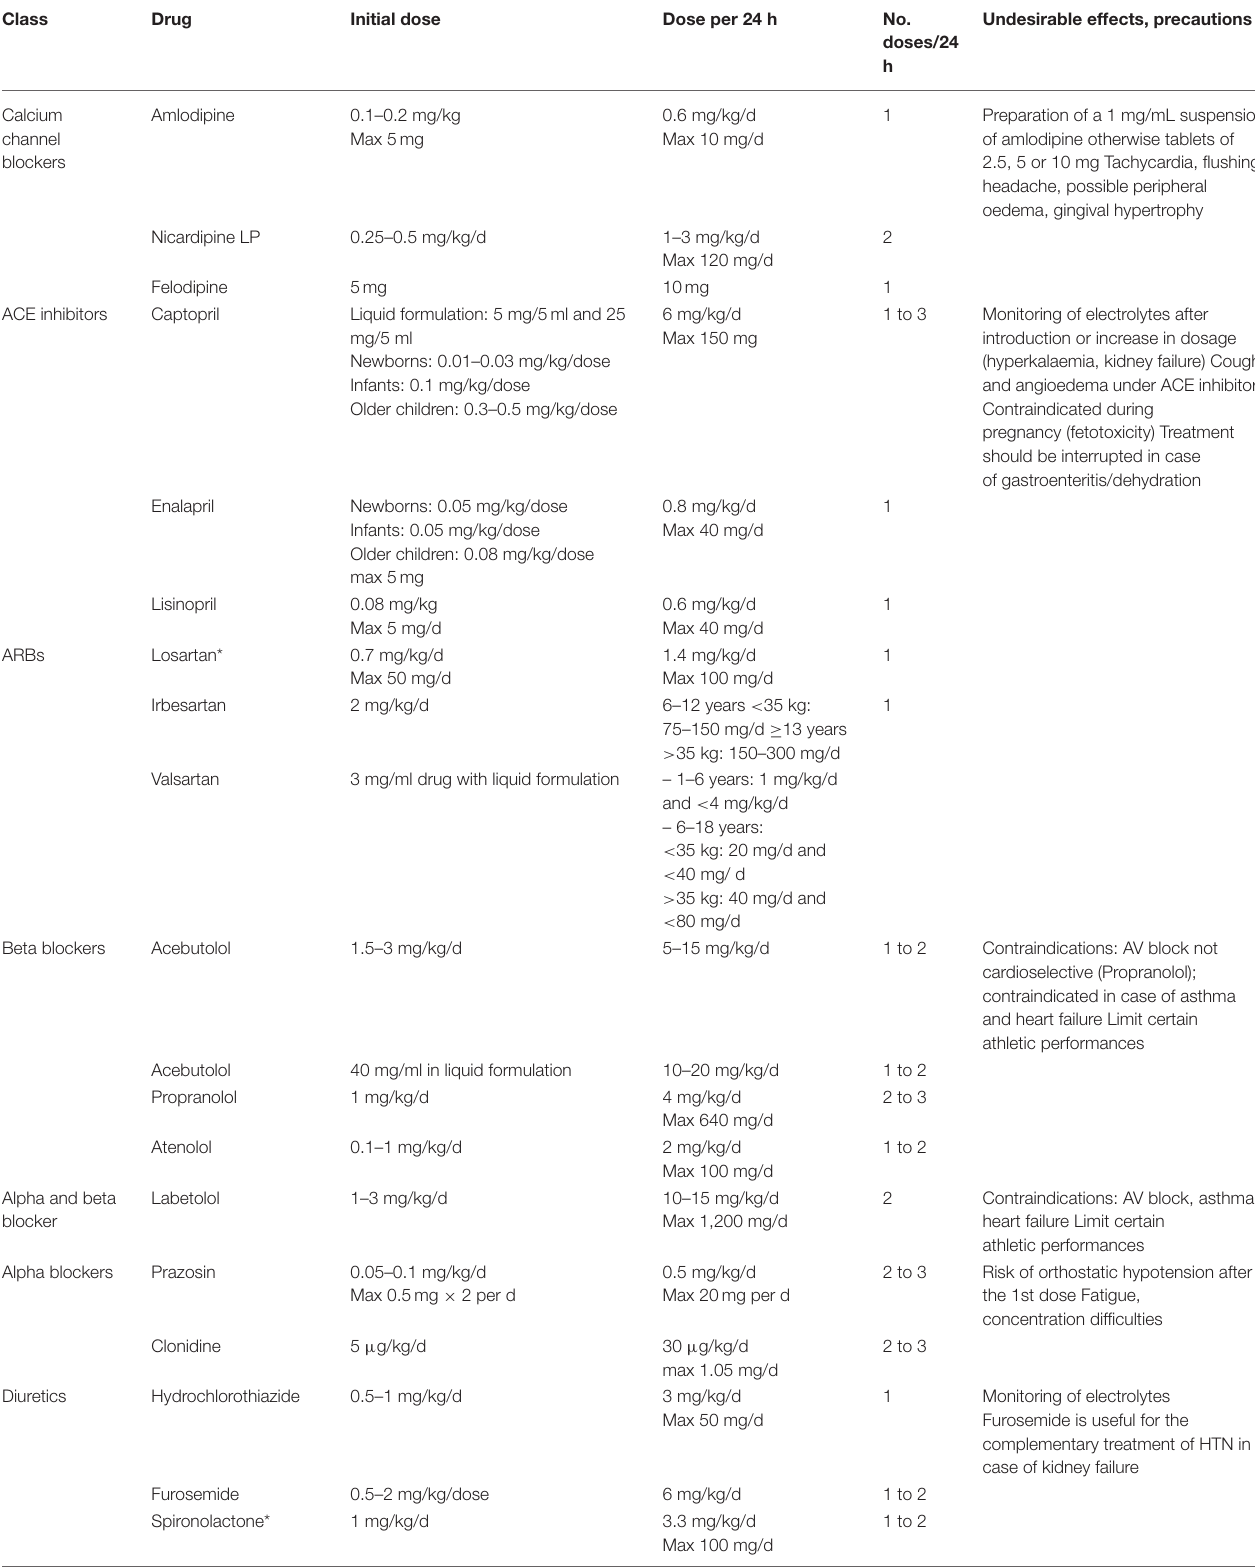
TABLE 5 | Main drug classes that can be used in